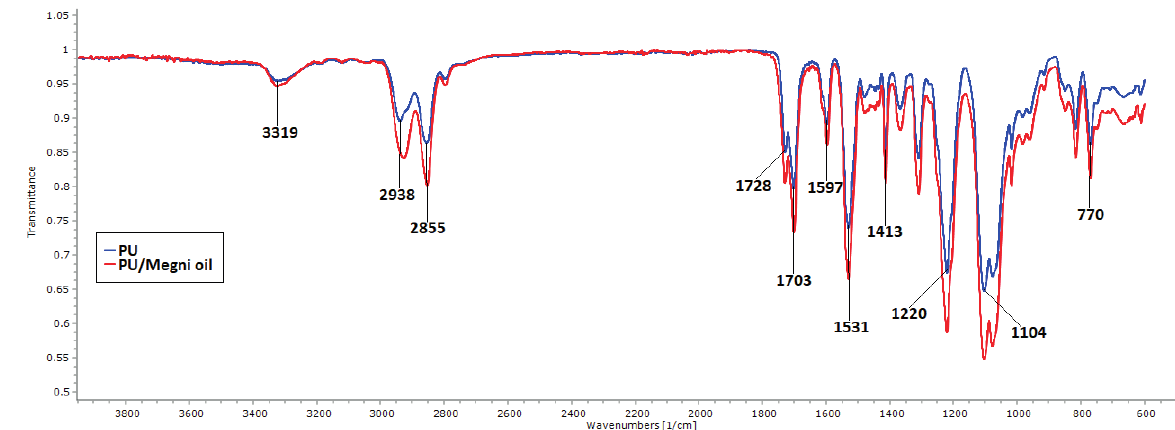
Figure 2 - IR spectrum of PU membrane and PU/Megni oil